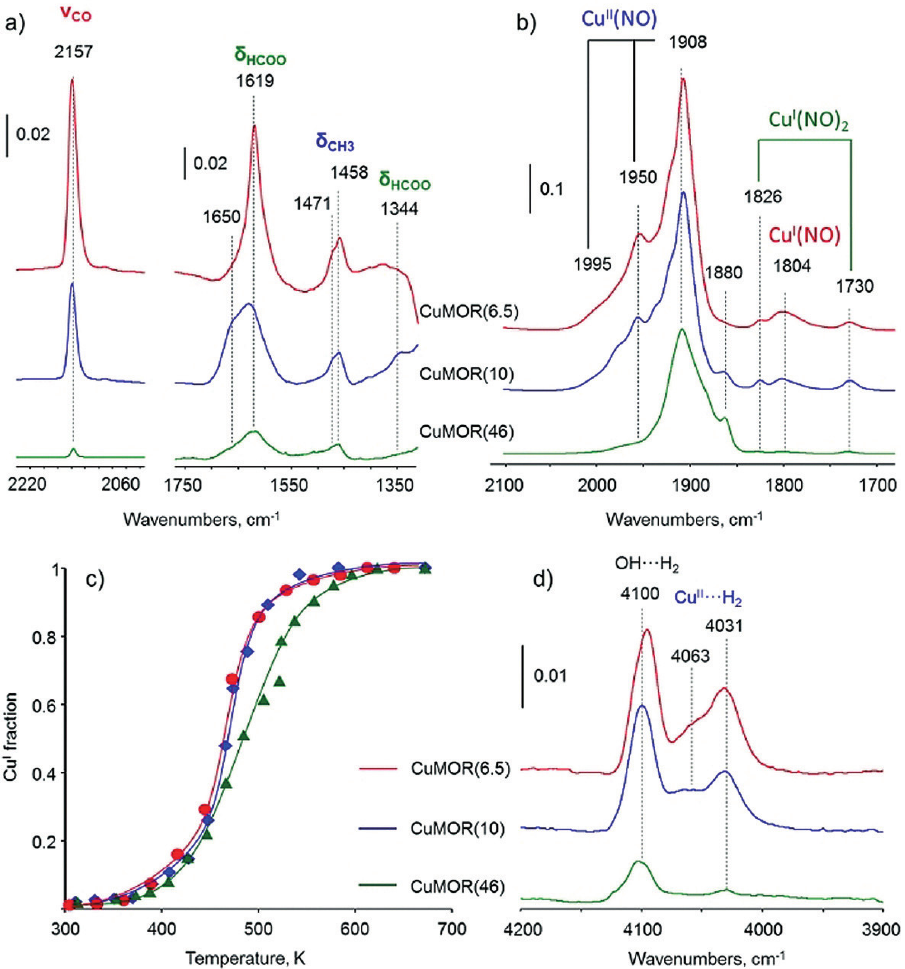
Figure 6. ( a ) In situ FTIR spectra of surface species formed in Cu-MOR samples with different Si/Al ratios (number in the brackets). ( b ) FTIR spectra of NO adsorbed over Cu-MOR. ( c ) Fitted XAS data obtained in the reaction of Cu-MOR with methane. ( d ) FTIR spectra of H 2 adsorbed on Cu-MOR. Reproduced with permission from ref [50]. Copyright 2018, Wiley-VCH.